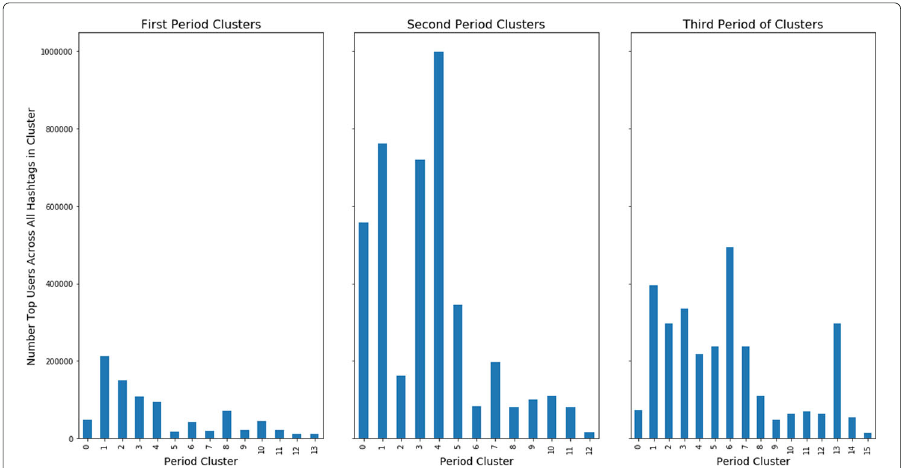
Fig. 8 Number of unique users for each cluster of hashtags in each time period. There are distinct differences between the number of unique users between and within periods. These differences are largely not driven by the number of hashtags present within a cluster, but rather with the topic of those